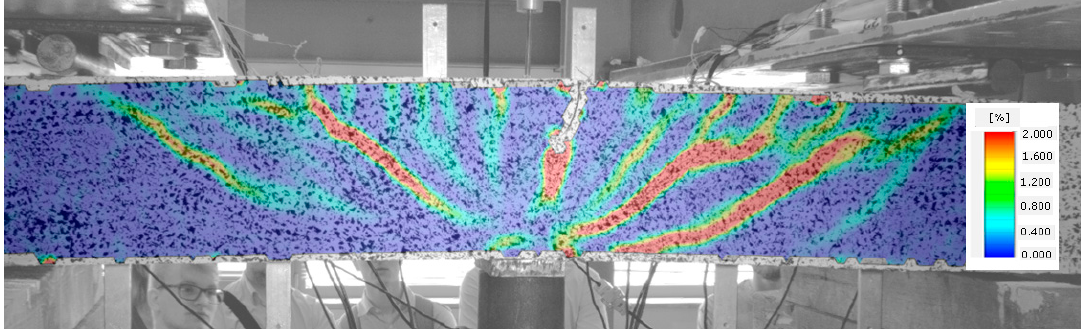
Beams with strong shear reinforcement (BFSb series) were destroyed due to their ar-